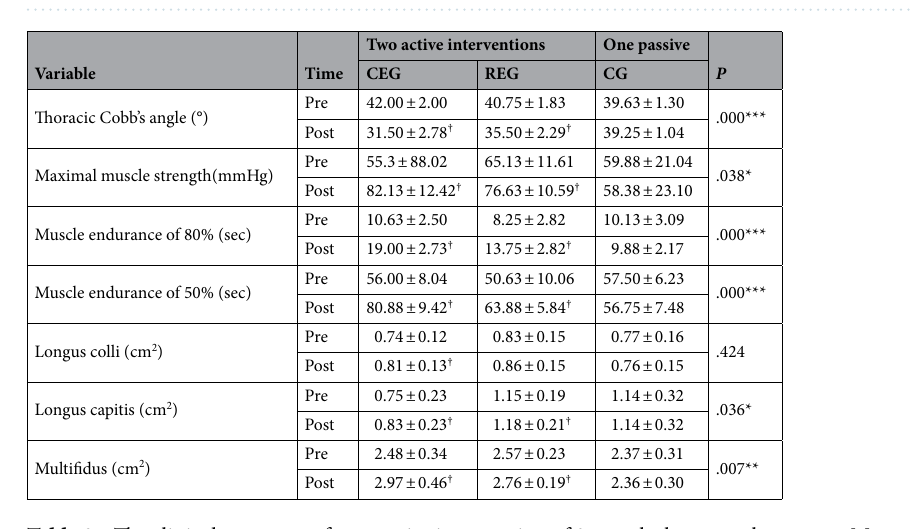
Table 2. The clinical outcomes after exercise intervention of 3 months between the groups. Mean ± standard deviation. CEG, corrective exercise group; REG, resistance exercise group; CG, control group. † P < 0.05, †† P < 0.01, ††† P < 0.001: the results from Wilcoxon singed rank test. * P < 0.05, ** P < 0.01, *** P < 0.001: the results from Kruskal–Wallis